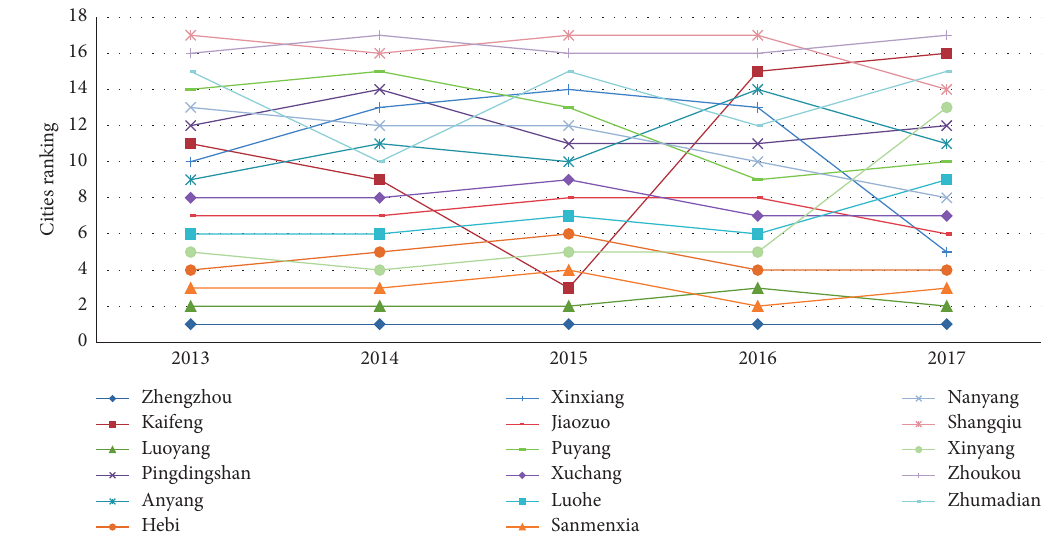
Figure 4: Ranking of urban sustainability in Henan Province from 2013 to 2017. Table 7: Global Moran index of the urban sustainability level.